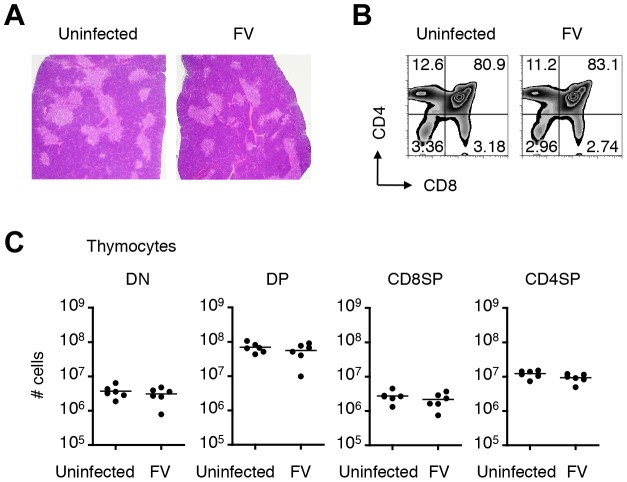
Infection of thymus with FV has no influence on numbers and frequencies of thymocyte populations.Mice were infected with 1,000 SFFU of FV. (A) Representative hematoxylin- and eosin-stained thymus sections from FV-infected (21 days post infection) or age-matched uninfected mice. Thymocytes isolated from the same experimental mice were stained for CD4 and CD8. Shown are representative dot plots (B) and actual numbers of each thymocyte population (C). Each symbol represents an individual mouse. No significant differences were observed between the groups. Data are representative of two independent experiments with essentially equivalent results.